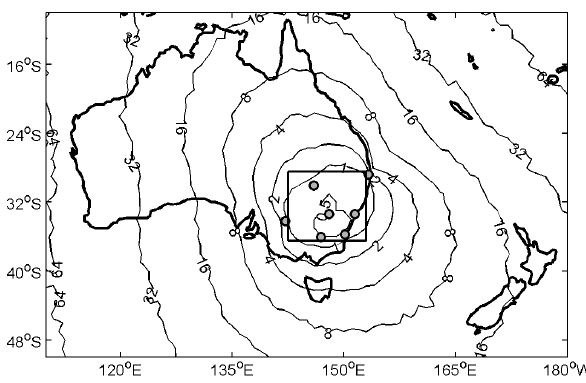
Fig. 2. The estimated location accuracy of the Kattron LPATS TOA lightning location network. The contours have units of